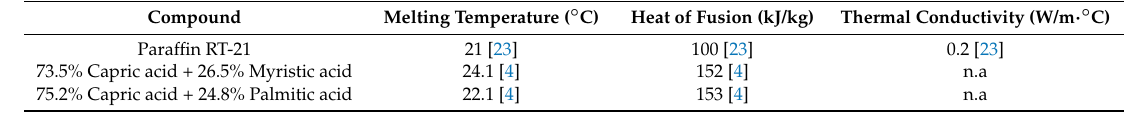
Table 1. Properties of PCM used on this study (from literature).